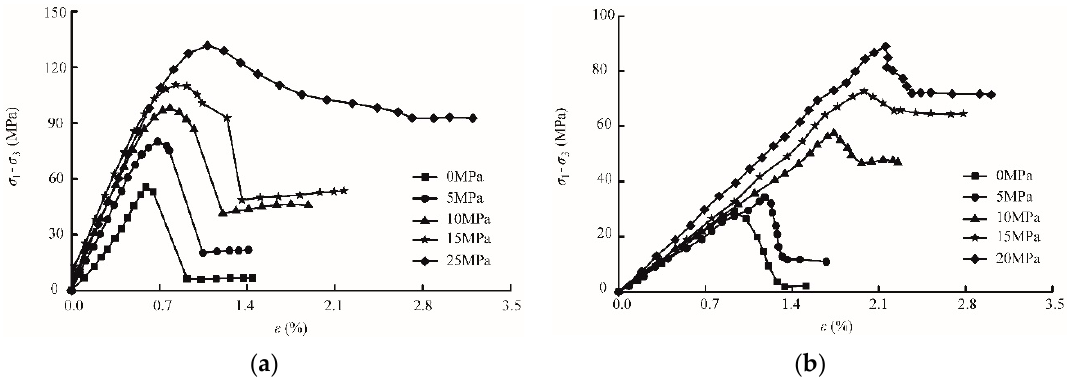
Figure 3. Complete stress ‒ strain curves of rock: ( a ) sandstone; ( b ) mudstone.